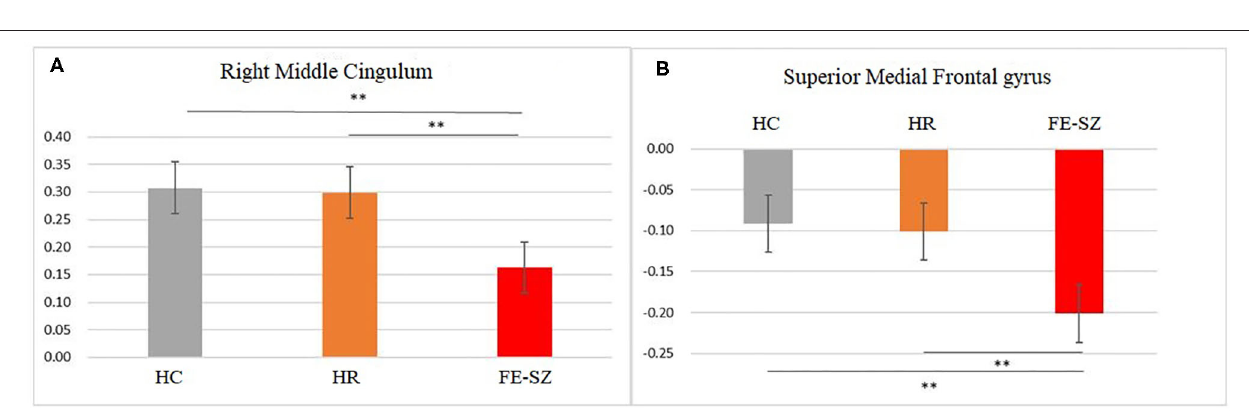
FIGURE 1 | ANCOVA results of amygdala (A) and hippocampus (B) functional connectivity. GRF corrected, voxel p < 0.001, cluster p < 0.05.